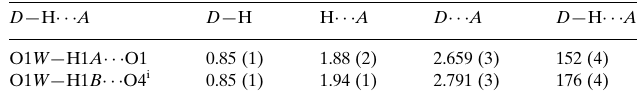
Hydrogen-bond geometry (A˚ , (cid:3)